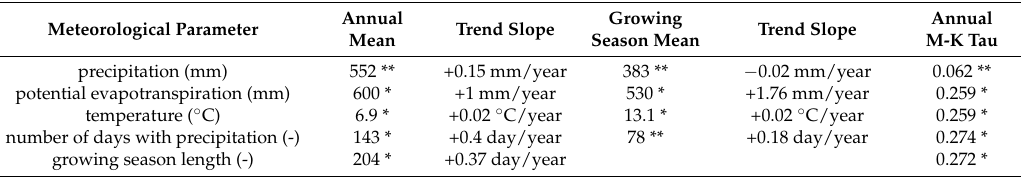
Figure 5. Perennial trends of ( a ) precipitation; ( b ) potential evapotranspiration; ( c ) temperature; ( d ) number of days with precipitation; ( e ) length of growing season. Table 2. Annual and growing season means of measured meteorological elements, and slope of their trends.